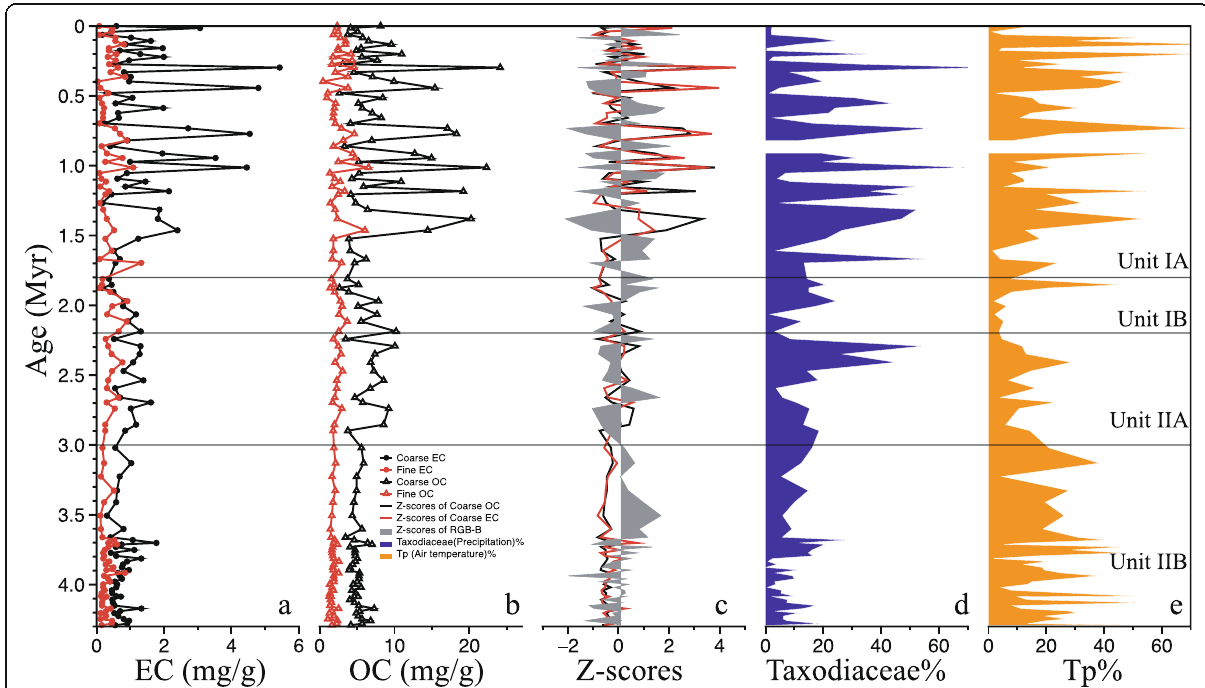
Fig. 5 Temporal variations in EC ( a ) and OC ( b ) contents and the relationship between Z-scores of brightness and carbon contents in the coarse fraction ( c ), abundance of Taxodiaceae pollen ( d ), and Tp value ( e ) at site U1423. EC and OC in the coarse fraction are represented as black solid line. EC and OC in the fine fraction are represented as red solid line. Z-scores for OC content, EC content, and brightness (RGB-B) are shown as black solid line, red solid line, and gray shades, respectively. The proportion of Taxodiaceae and Tp are shown as blue shades and orange shades,